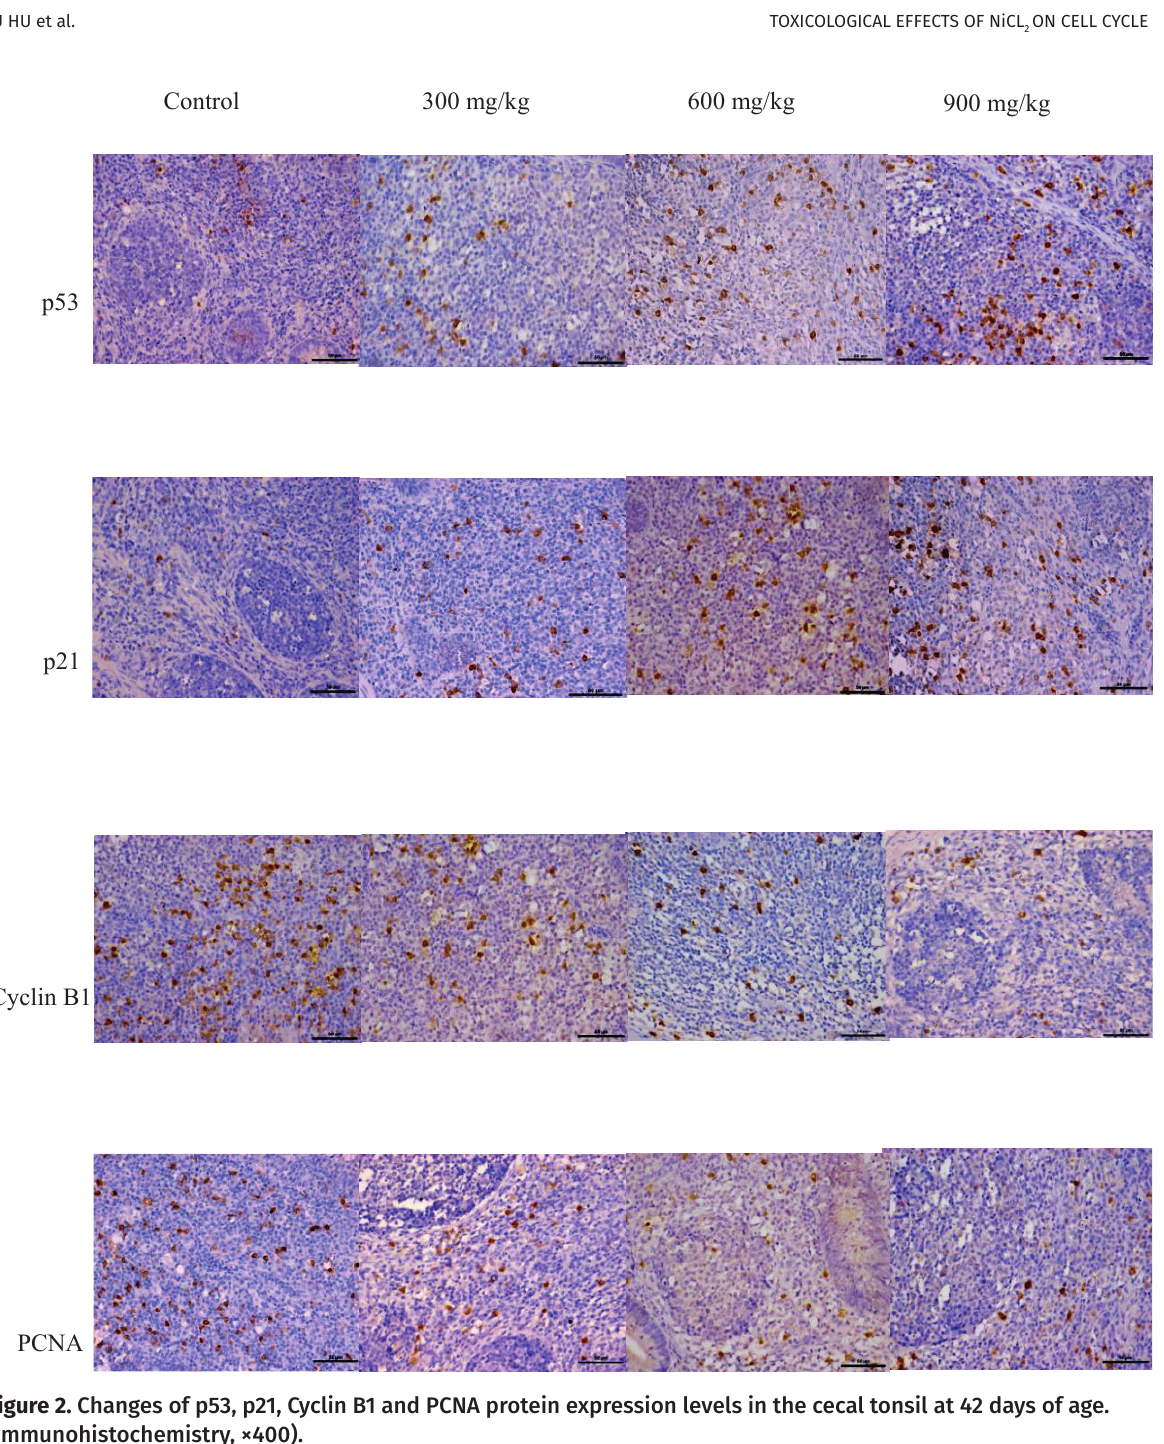
Figure 2. Changes of p53, p21, Cyclin B1 and PCNA protein expression levels in the cecal tonsil at 42 days of age. (Immunohistochemistry,